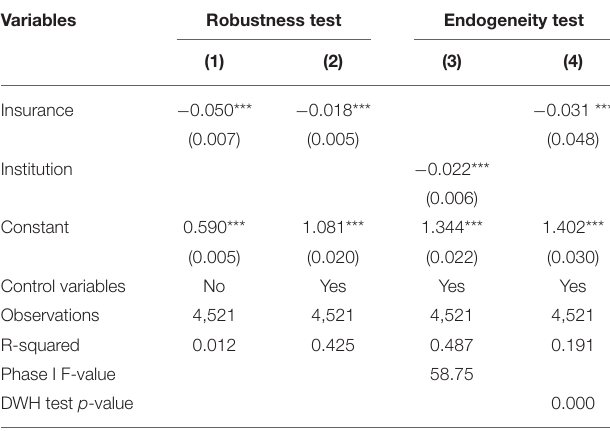
TABLE 3 | The benchmark regression result. TABLE 4 | Results of robustness test and endogeneity